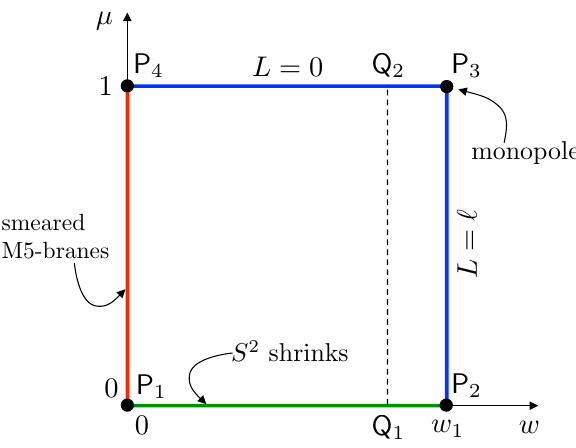
Figure 2. The internal space in the 11d solution is an S 1 in the ( w, µ ) plane delimited by the points P function L in the line element (2.25) on the sides P